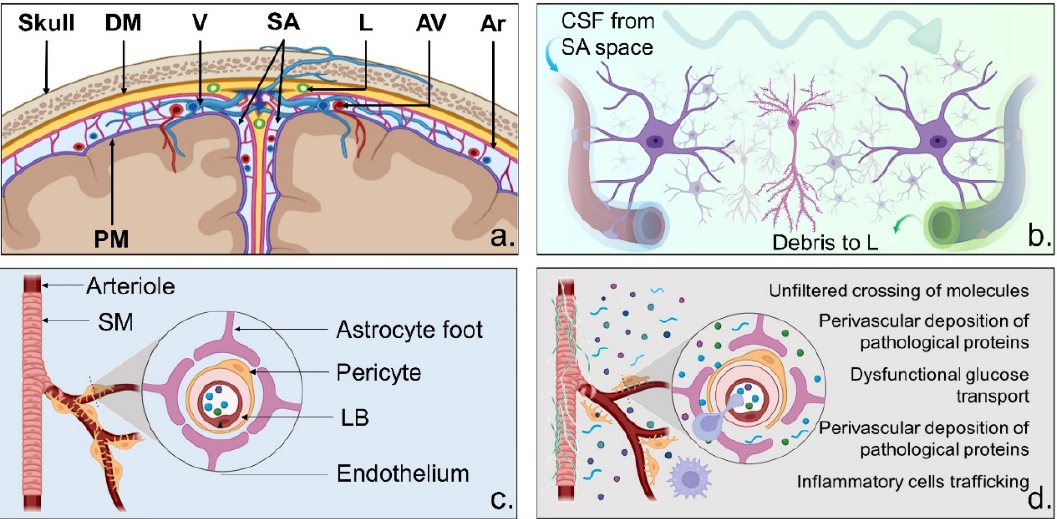
Figure 1. The missing link. The figure depicts the anatomy and physiology of the neurovascular and glymphatic systems. ( a ) Neuroanatomy of the meninges. ( b ) Schematization of the glymphatic system, showing the entry of CSF within the paravascular space, permeating towards the veins, where it is collected along with neurotoxic molecules and drained into dural lymphatics. Engulf- ment of this system induces accumulation of debris, including neuroinflammatory and nociceptive mediators and misfolded proteins. ( c ) Physiological composition of the blood–brain barrier (BBB). The layers properly filter the arterial blood, and only selected molecules may cross. ( d ) Disruption of the BBB and related pathological changes. Abbreviations: Ar = arachnoid; AV = arterial vessel; CSF = cerebrospinal fluid; DM = dura mater; L = lymphatics; LB = lamina basalis; PM = pia mater; SA = subarachnoid space; SM = smooth muscle; V = vein.